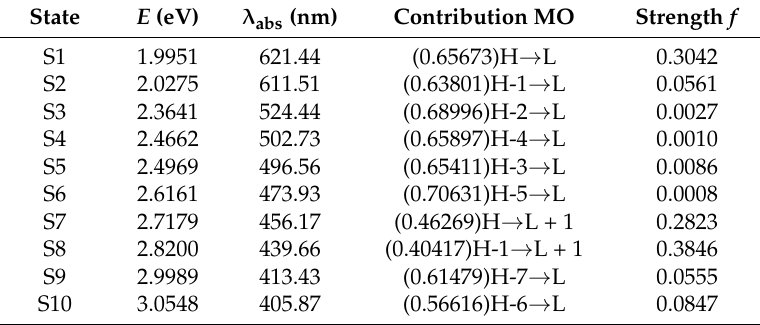
Figure 4. Simulated absorption spectra of chlorophyll in ethanol via different functionals with 6-31G(d) basis set. Table 3. Calculated excitation energies ( E , eV), absorption peaks ( λ abs , nm), electronic transition configurations and corresponding oscillator strengths ( f ) of chlorophyll a in ethanol by using TD-DFT//PBEPBE/6-31G(d) method.